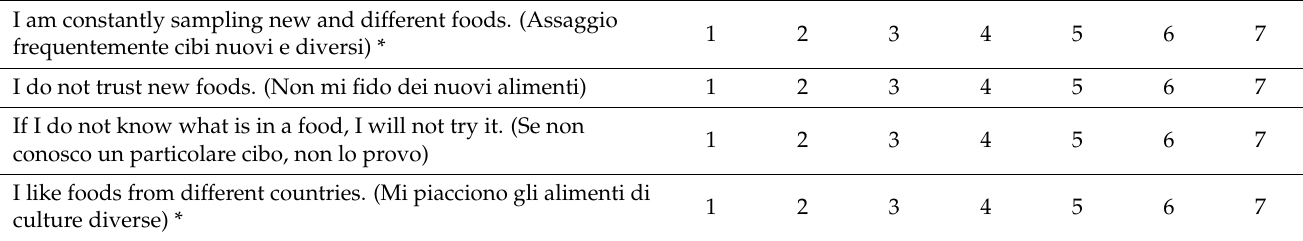
Table A1. Food Neophobia Scale (FNS, Pliner and Hobden, 1992; Ritchey et al., 2003); in brackets: Italian